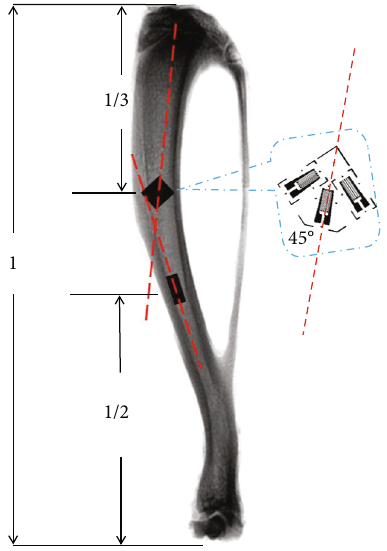
Figure 1: Locations of strain gauges (red line: long